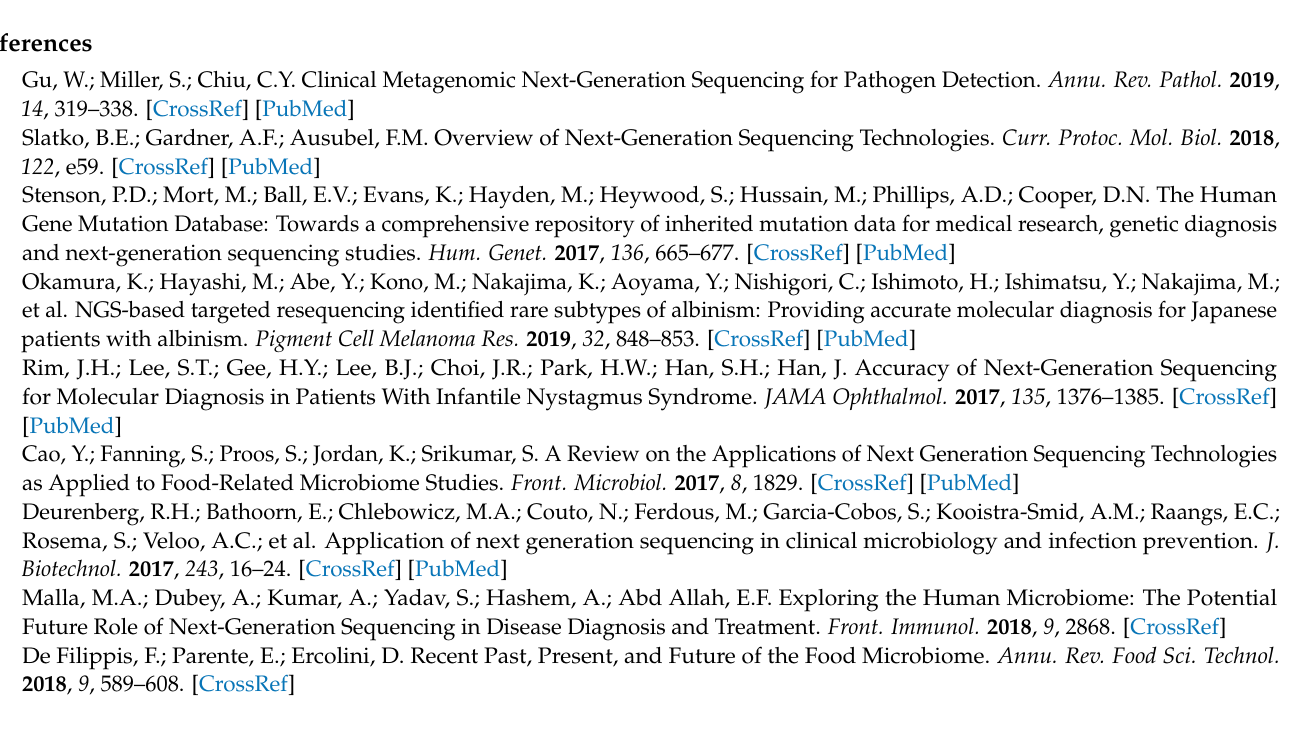
Table S6: Measurement about bacterial proportion data exported by qRT-PCR and NGS; Table S7: Bacterial identification results of each genus by BLAST